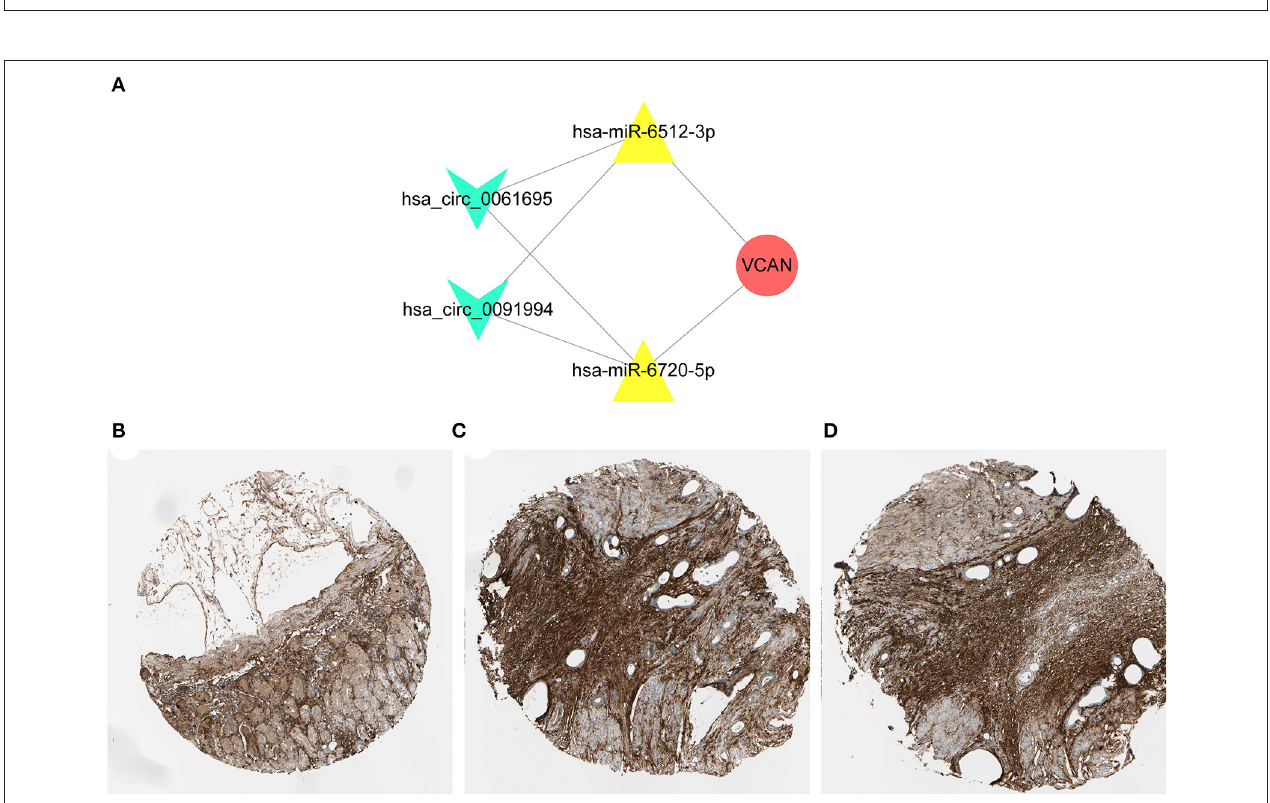
FIGURE 6 | Construction of regulatory axis. (A) The key axis in the circRNA-miRNA-mRNA network of GC was constructed by hsa_circ_0061695, hsa_circ_0091994, hsa-miR-6512-3p, hsa-miR-6720-5p, and VCAN. (B–D) The immunohistochemical staining results indicated that a higher expression level of VCAN was confirmed in the tumor tissues. The samples of normal tissue (B) and two tumor tissues (C,D) were obtained from one patient. Concrete information at https://www.proteinatlas.org/.